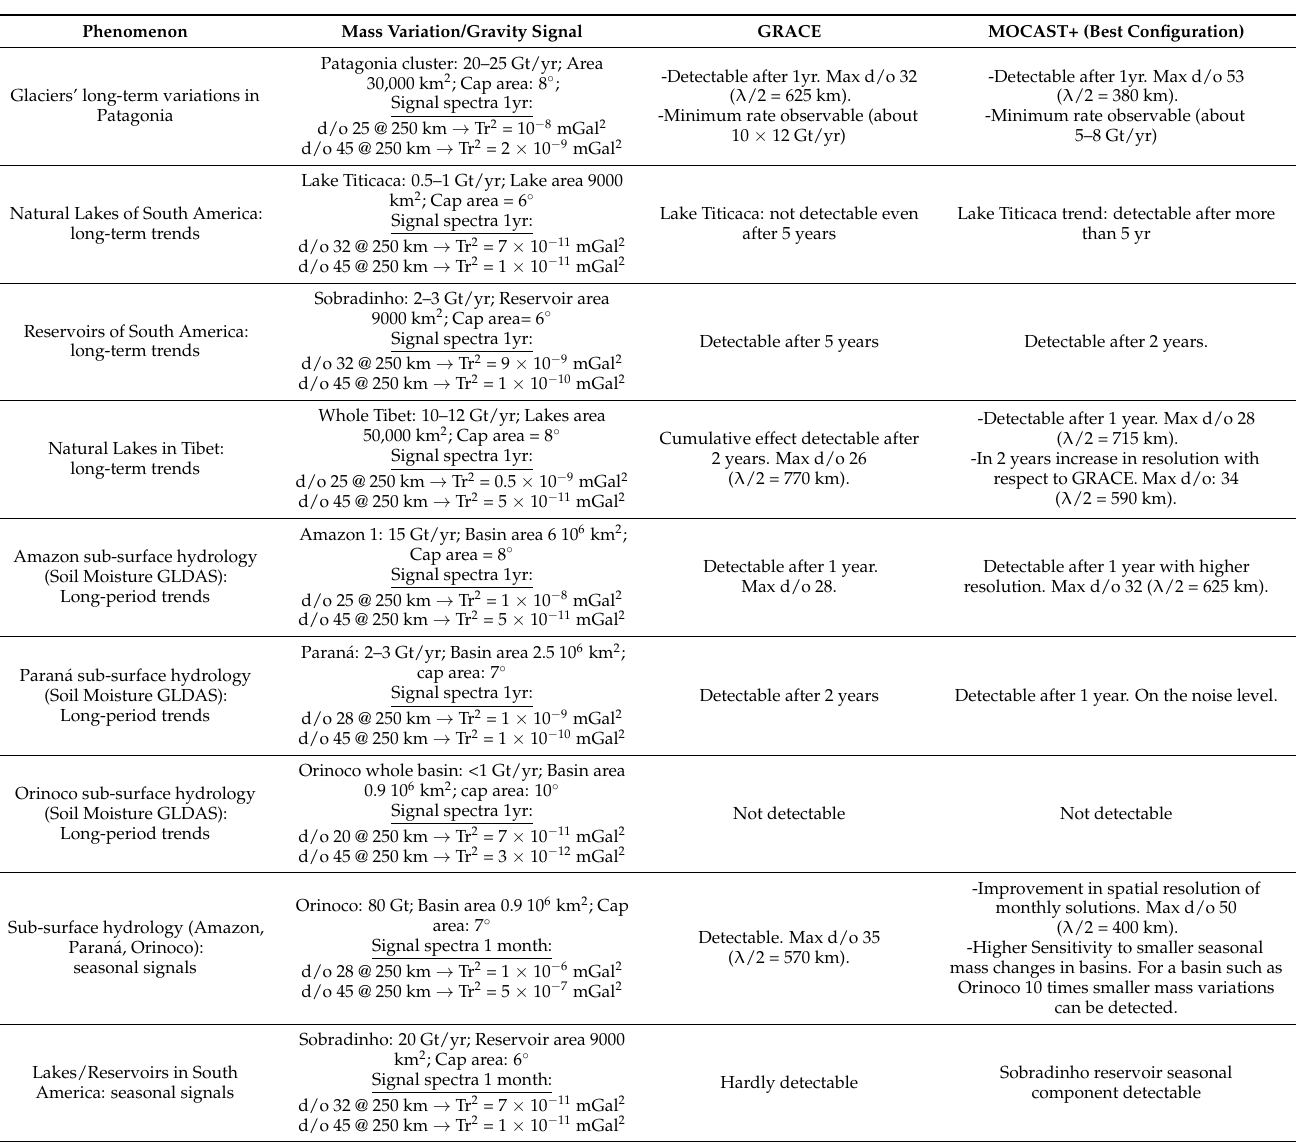
Table 3. Overview of the detectability of geophysical signals by GRACE and MOCAST+. For MOCAST+, the comparison is relative to GRACE. d/o = degree and order; λ /2 = half-wavelength of highest resolvable